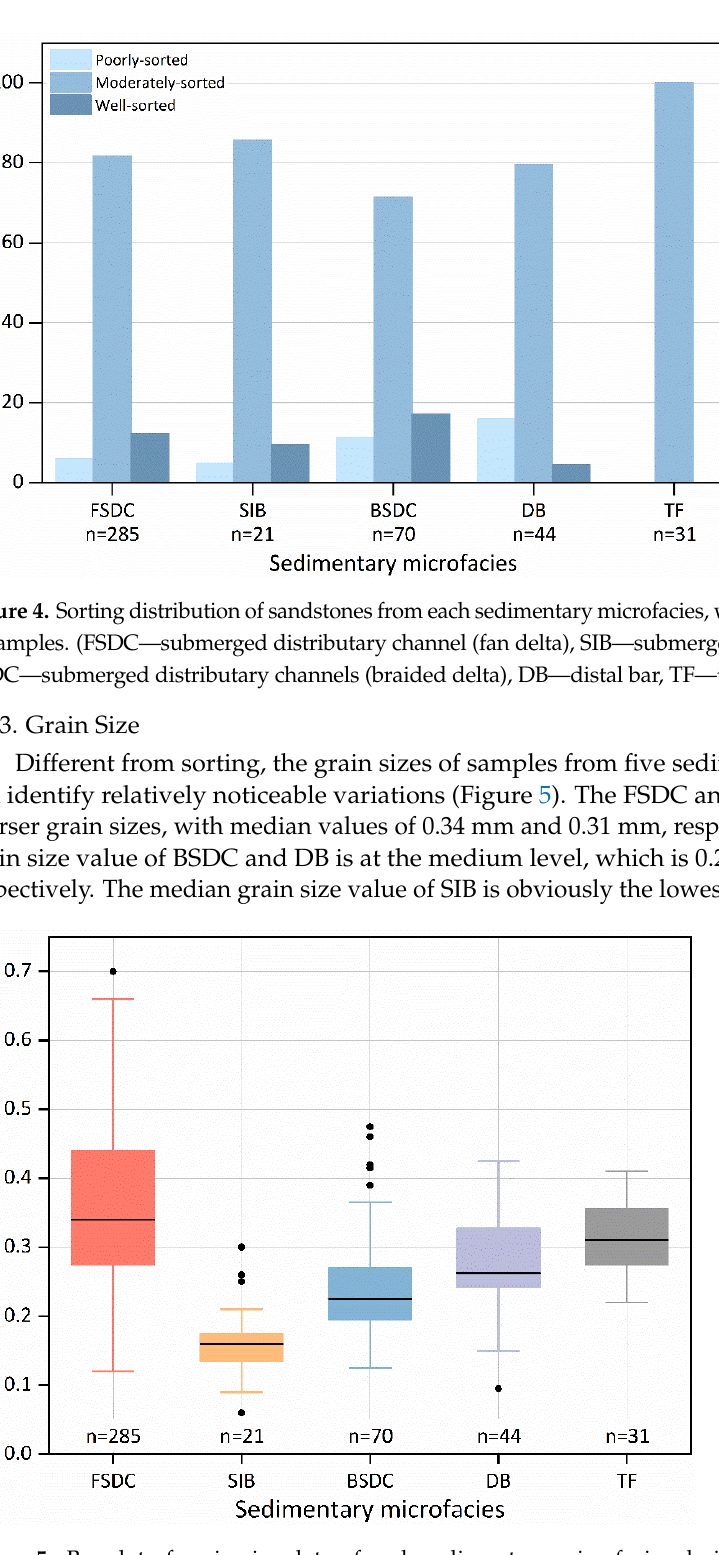
Figure 5. Boxplot of grain size data of each sedimentary microfacies derived from point count, where “n” is the number of samples. Each box displays data between the upper and lower quartile, and the black line represents the median. The highest and lowest values are revealed by the whiskers. Over 1.5 times the upper or lower quartile are considered outliers marked by black dots. (FSDC — submerged distributary channel (fan delta), SIB — submerged interdistributary bay, BSDC — submerged distributary channels (braided delta), DB — distal bar, TF — turbidite fan).